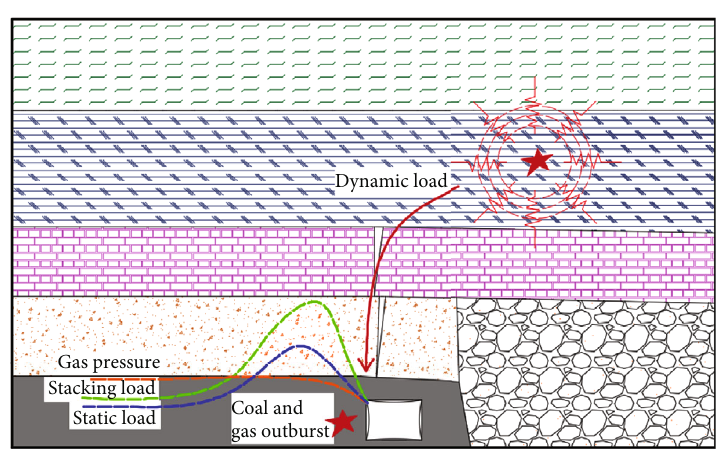
Figure 2: Model of shock-type coal and gas outburst